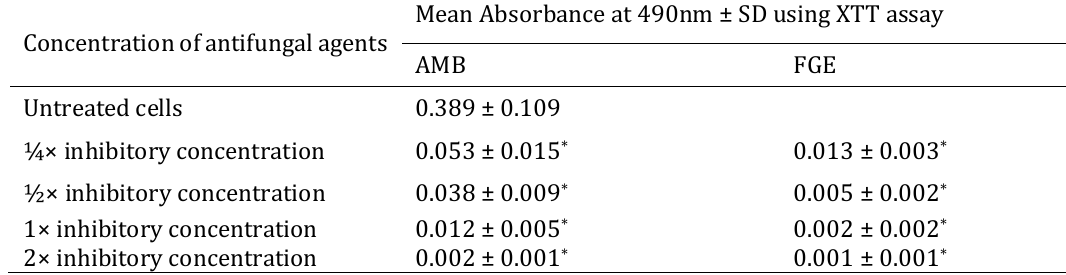
FGE; ¼× inhibitory concentration = 25 mg/mL, ½× inhibitory concentration = 50 mg/mL, 1× inhibitory concentration = 100 mg/mL and 2× inhibitory concentration = 200 mg/mL and AMB; ¼× inhibitory concentration = 0.0625 µg/mL, ½× inhibitory concentration = 0.125 µg/mL, 1× inhibitory concentration = 0.25 µg/mL and